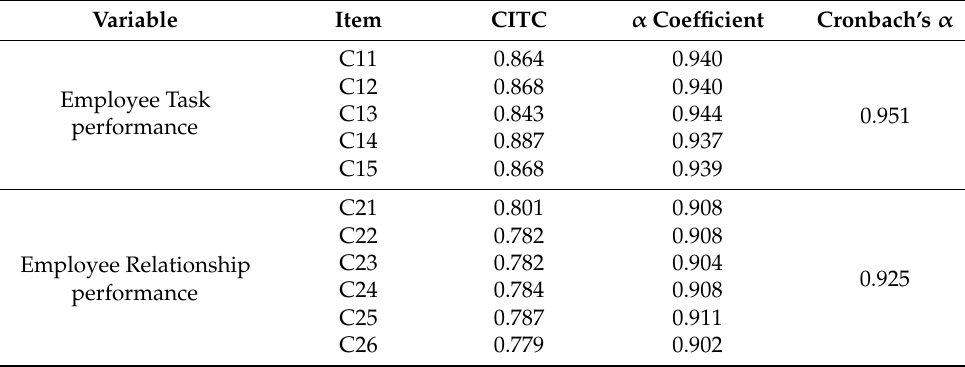
Table 7. Reliability Analysis of Employee Work Performance.